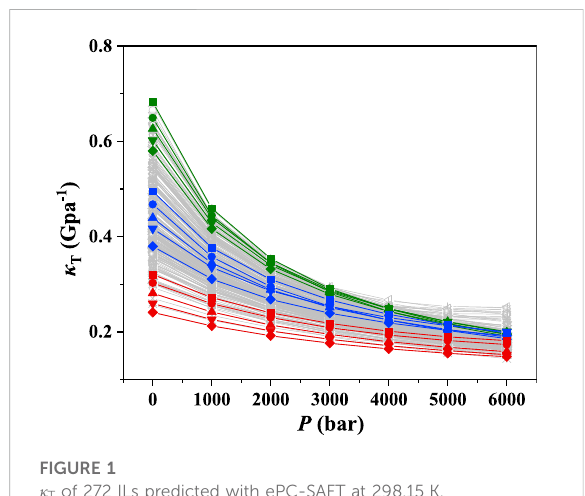
FIGURE 1 κ T of 272 ILs predicted with ePC-SAFT at 298.15